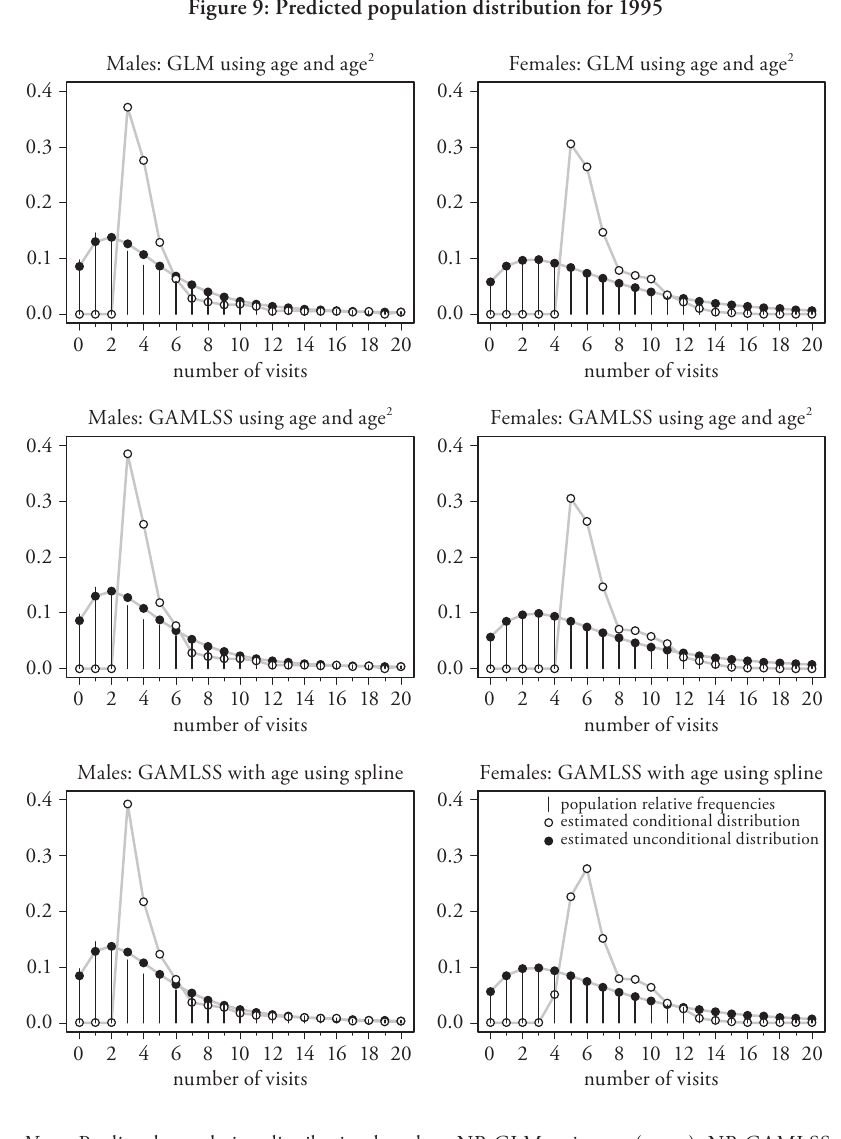
Figure 9: Predicted population distribution for